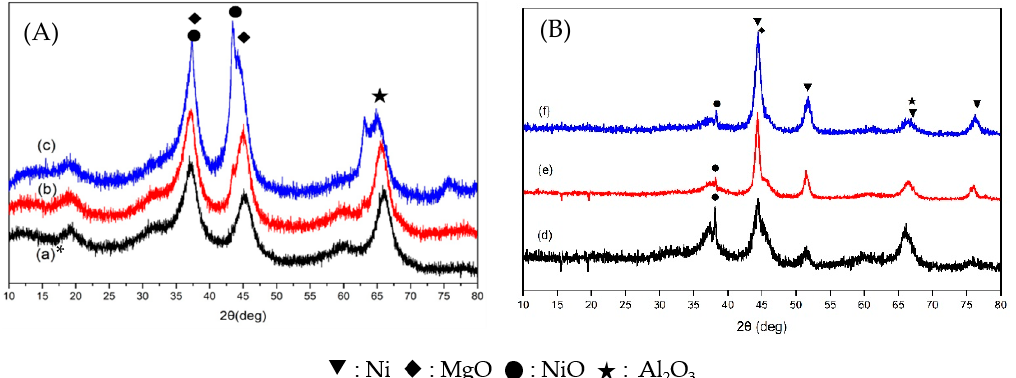
Figure 12. XRD patterns of fresh Ni-Mg-Al catalysts (a) 20 wt% Ni (b) 40 wt% Ni, or (c) 60 wt% Ni and spent catalysts (d) 20 wt% Ni (e) 40 wt% Ni, or (f) 60 wt% Ni (( A ) fresh, ( B ) spent)(* reference [41] was cited ).